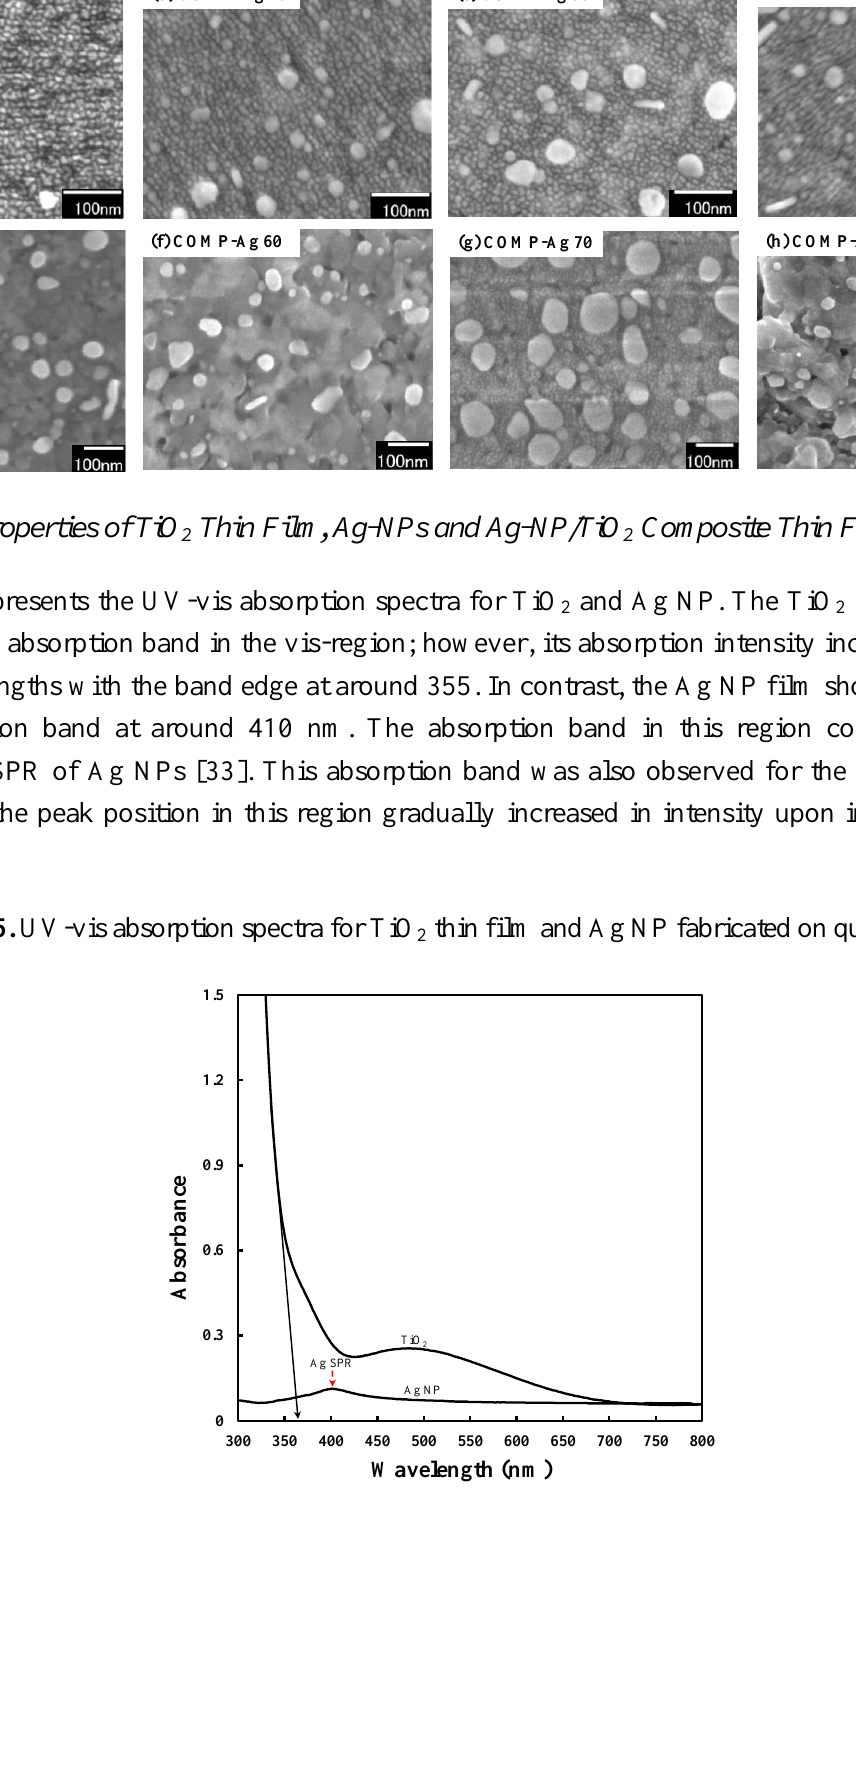
composite thin films at various amounts of Ag 2